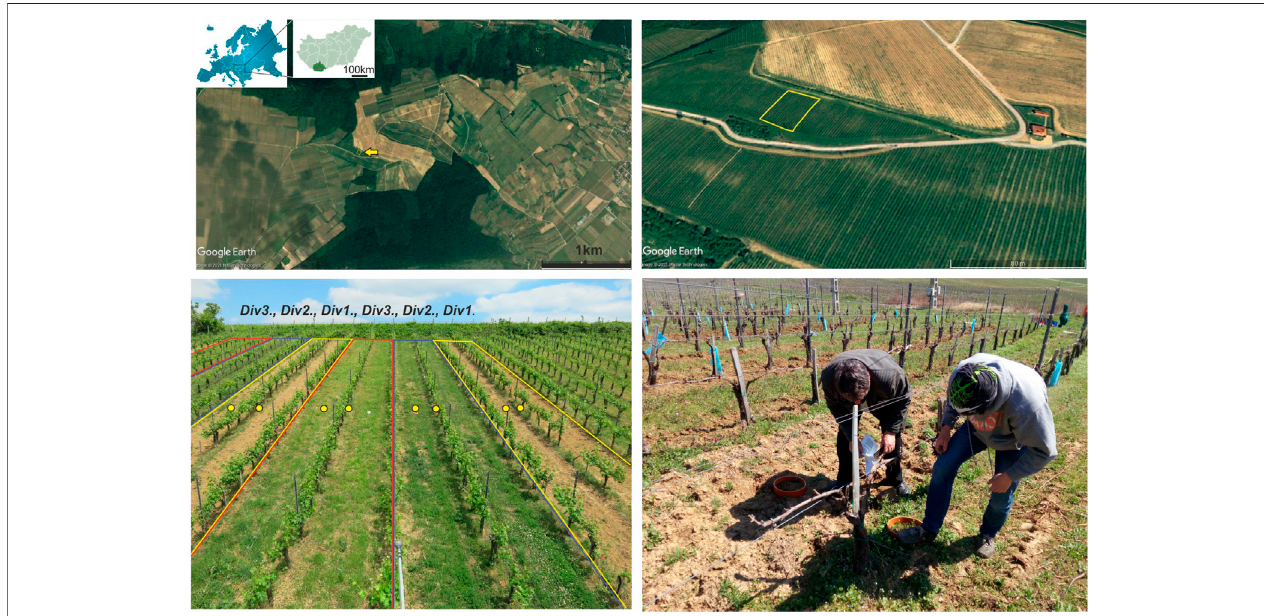
FIGURE 3 | Villány, location of CS11 area (A,B) , a part of treatments and place of the chambers, (C) setting chambers (D) .